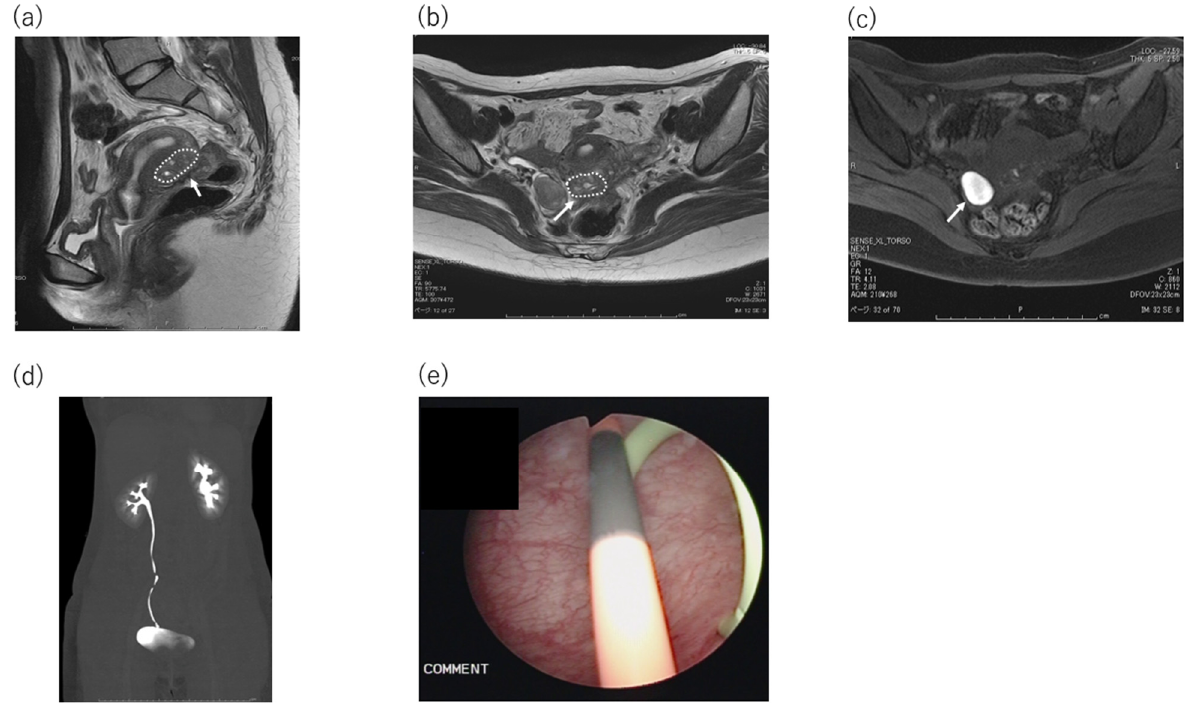
Figure 1. ( a , b ) T2-weighted image sagittal and axial sections showing extrinsic adenomyosis in the posterior wall of the uterus (white dotted circle), which was adherent to the sigmoid colon (white arrow). ( c ) T1-weighted image with fat suppression showing a high-intensity, 2-cm ovarian endometrioma (OMA) on the right (white arrow). ( d ) Contrast-enhanced computed tomography (CT) showing prominent left hydronephrosis. The left ureter also showed contrast delay. The left ureter was suspected to be compressed by the deep endometriosis (DE). ( e ) A left ureteral double-J stent was inserted using cystoscopy.